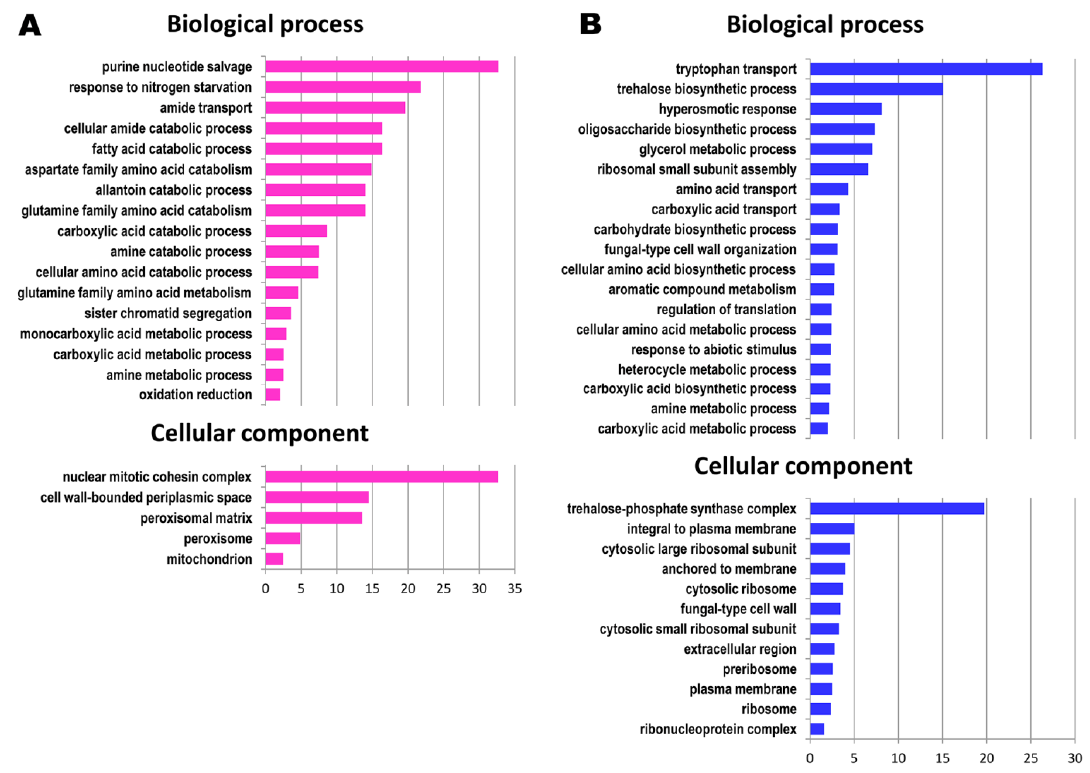
Figure 1. Overrepresentation of Gene Ontology (GO) terms in the group of upregulated ( A ) and downregulated ( B ) genes selected in the course of transcriptome analysis. The analysis was performed using Cytoscape (v3.8.0) [18] with the BiNGO (v3.0.3) plugin [19] and GO Slim Term Mapper (https://www.yeastgenome.org/goSlimMapper). GO terms belonging to Biological process and Cellular Component categories are shown.